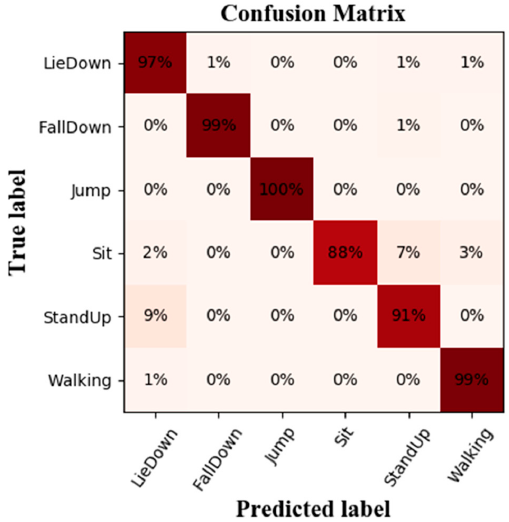
Figure 10. The confusion matrix of the model.